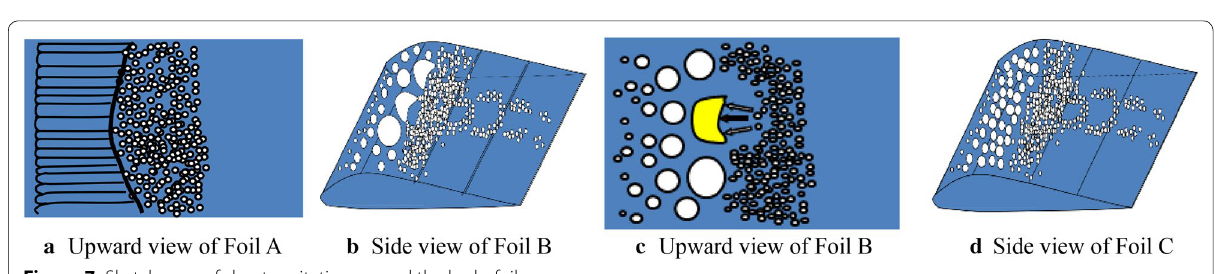
Figure 7 Sketch map of sheet cavitation around the